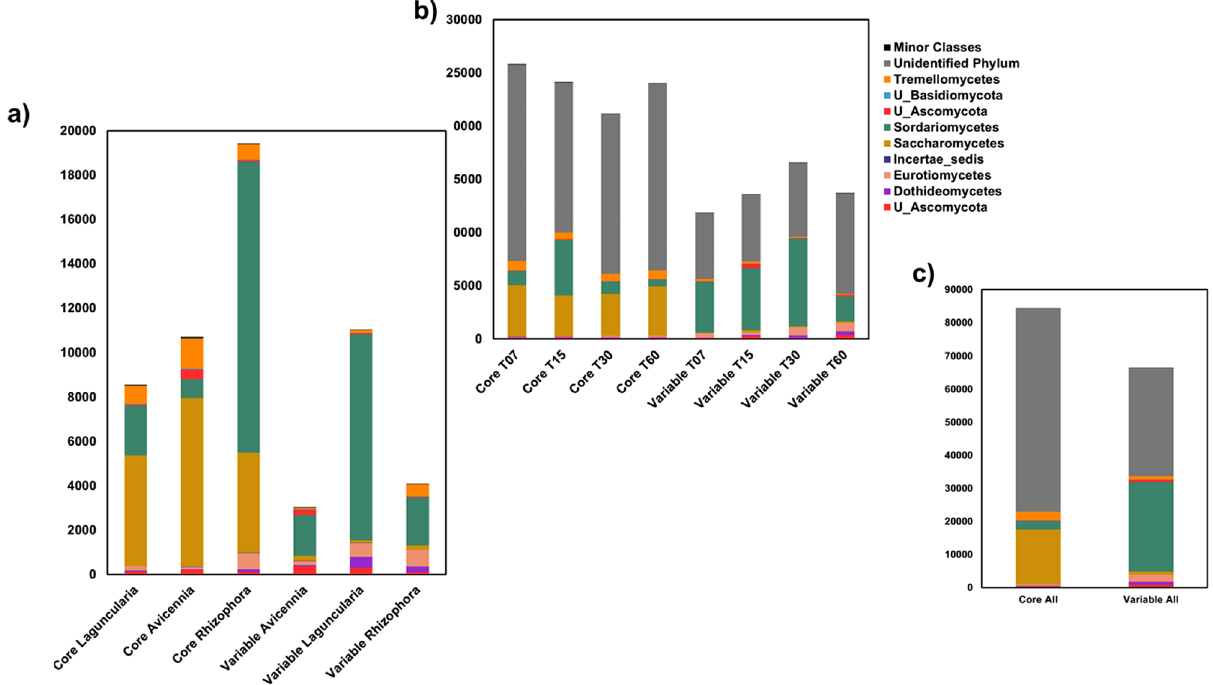
Figure 4. Relative abundance of the OTUs classified as belonging to the core or variable communities determine by the Poisson distribution in the three studies plant species ( Avicennia schaueriana, Laguncularia racemosa and Rhizophora mangle